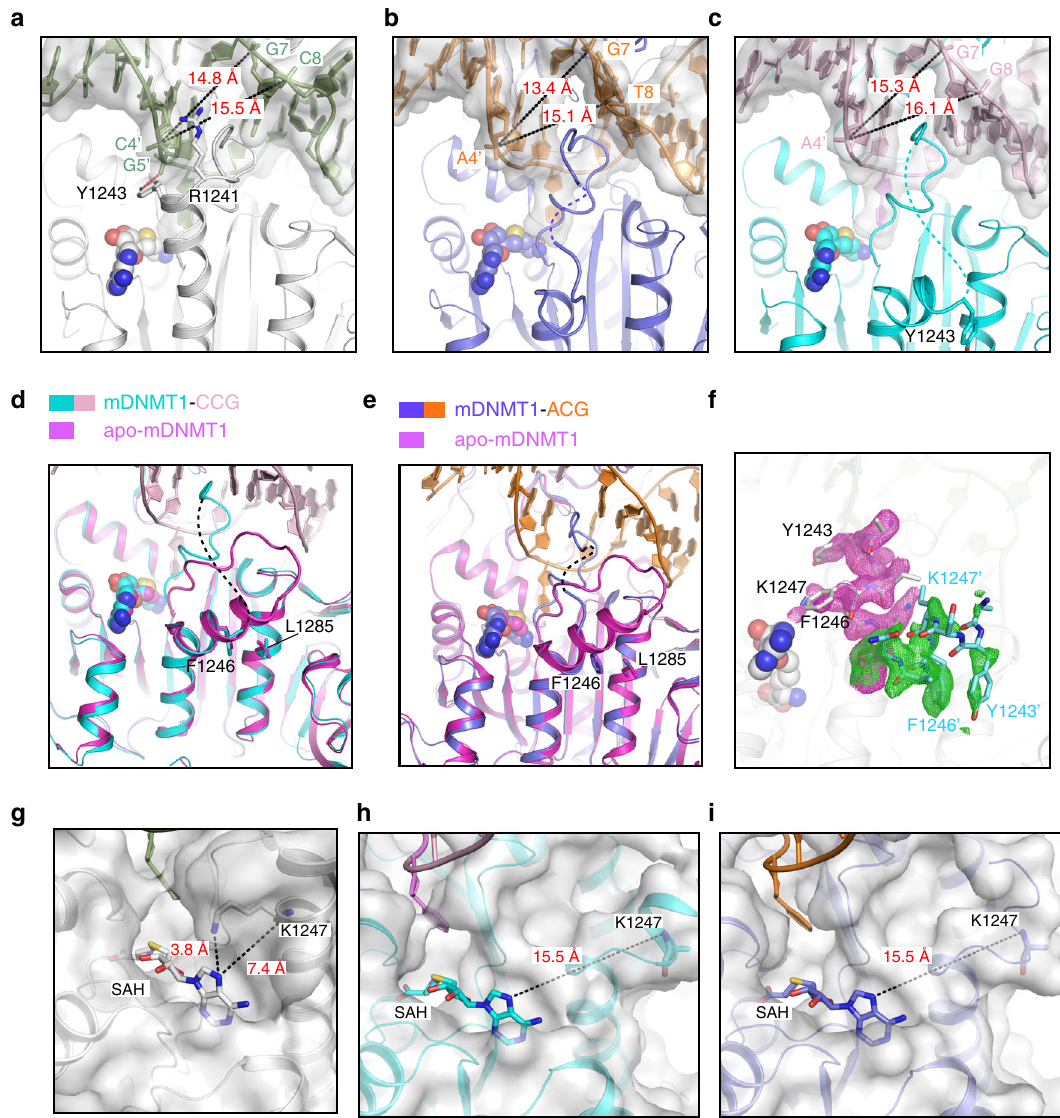
Fig. 5 Conformational transition of the catalytic helix of murine DNMT1. Close-up views of the conformation of the catalytic helix in the GCG (PDB 4DA4) ( a ), ACG ( b ), and CCG ( c ) complexes. The side chains of the DNA-interacting residues R1241 and Y1243 are shown in stick representation in the GCG complex ( a ). These two residues are either completely (in the ACG complex) or partially (CCG complex) non-traceable in the other two complexes. The hydrogen-bonding interaction is shown as dashed line in red. The minor groove width at the + 2 fl ank sites (C4 ′ /A4 ′ ) is indicated by dashed lines in black. The disordered segments in ( b ) and ( c ) are shown by dashed lines in slate and cyan, respectively. Close-up view of the catalytic helix overlaid between a DNMT1 structure with no DNA bound to the catalytic domain (PDB 3PT9) and the CCG complex ( d ) or the ACG complex ( e ). Fo-Fc omit map of residues 1242 – 1249 of mDNMT1 731 – 1602 in the GCG DNA complex (PDB 4DA4). The straight conformation and associated map (2.0 σ level) are colored in silver and magenta, respectively. The kinked conformation and associated map (1.9 σ level) are colored in aquamarine and green, respectively. Enlargement of the AdoMet-binding pockets in the GCG ( g ), CCG ( h ) and ACG ( i ) complexes. The distances between the N7 atom of AdoHcy (SAH) and the side chain or the backbone of residue K1247 are indicated by dashed lines. Note that the side chain of K1247 is non-traceable in ( h – i ) due to missing electron